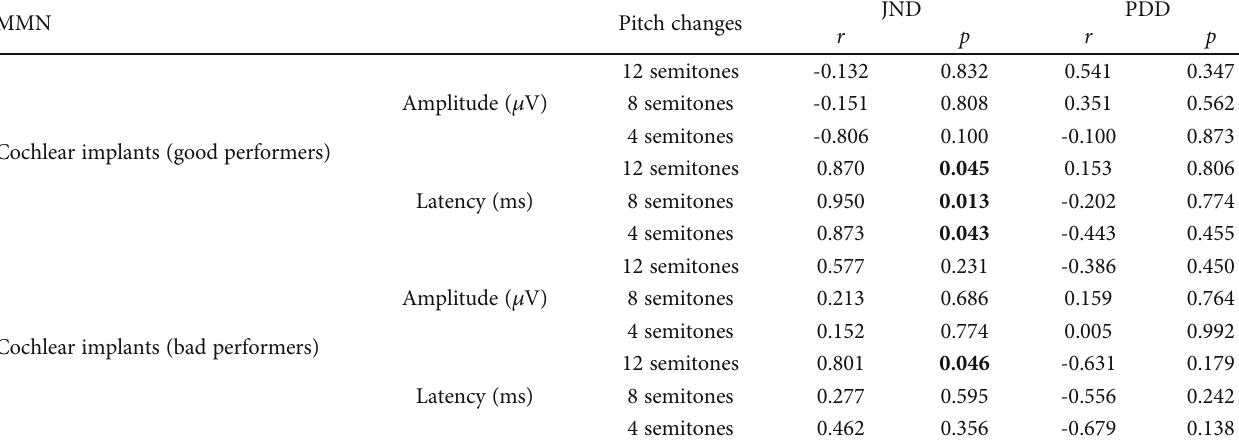
Cochlear implants (bad